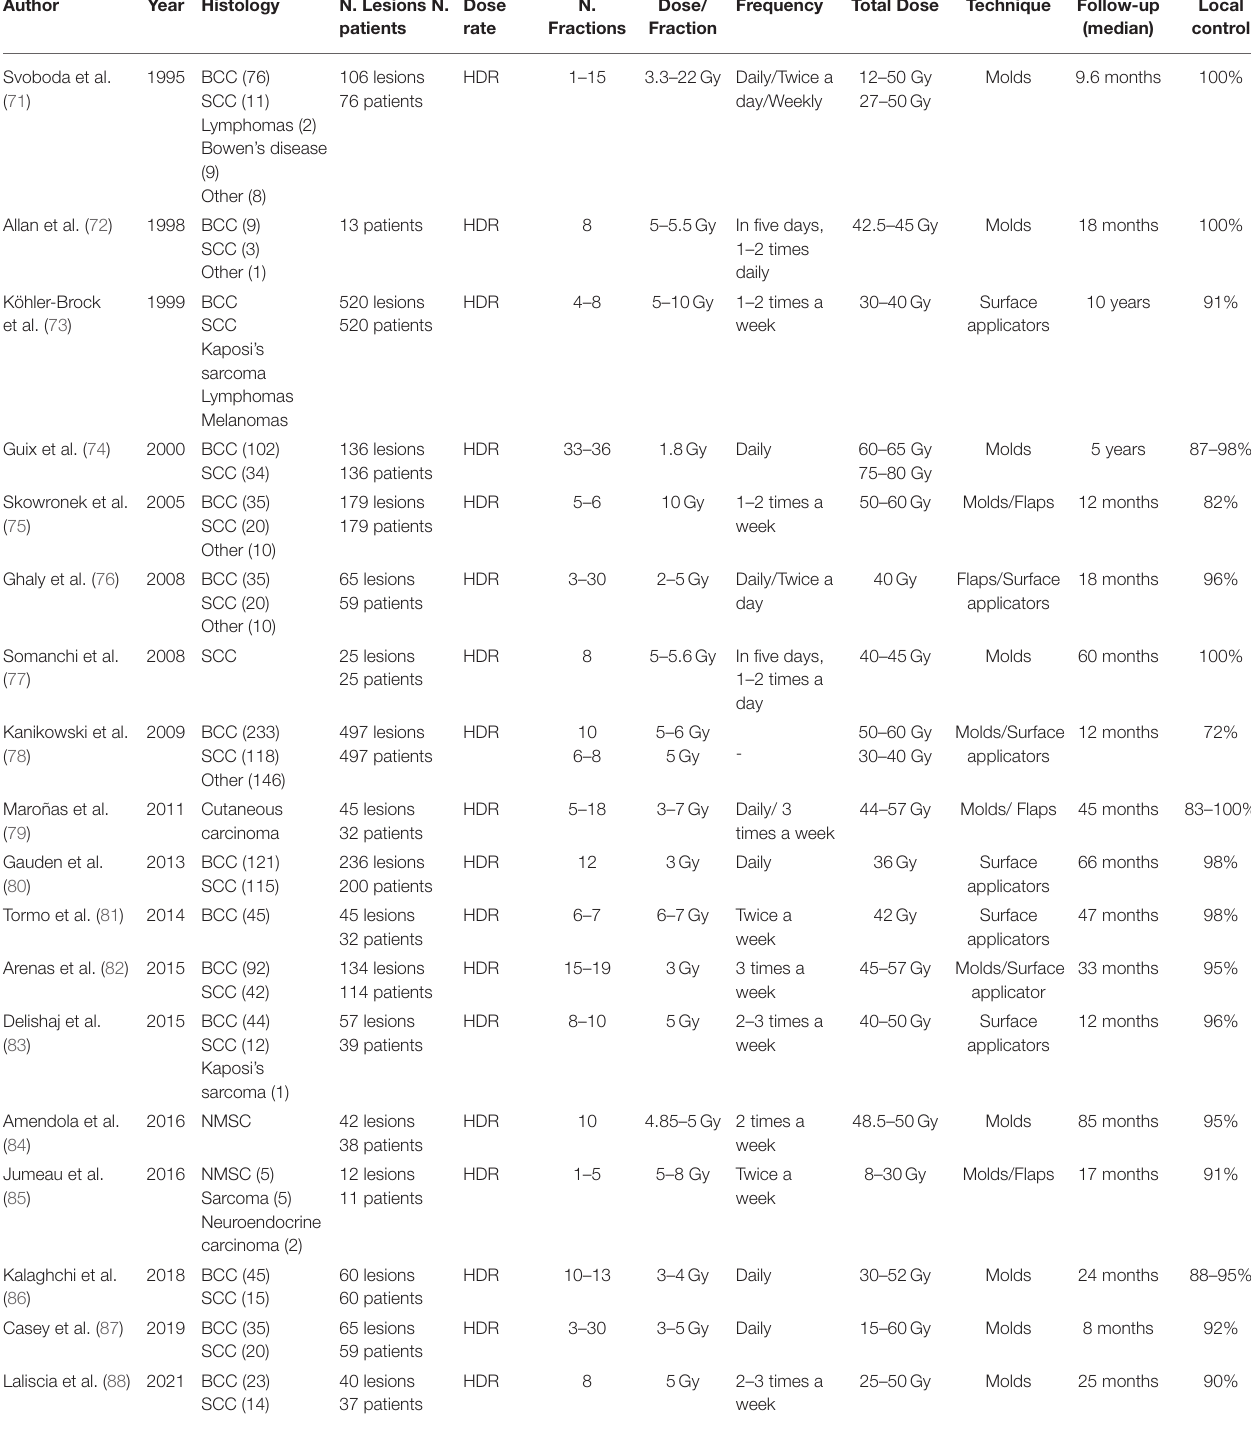
TABLE 2 | Contact brachytherapy, customized molds and flaps, Leipzig and Valencia applicators, combination of